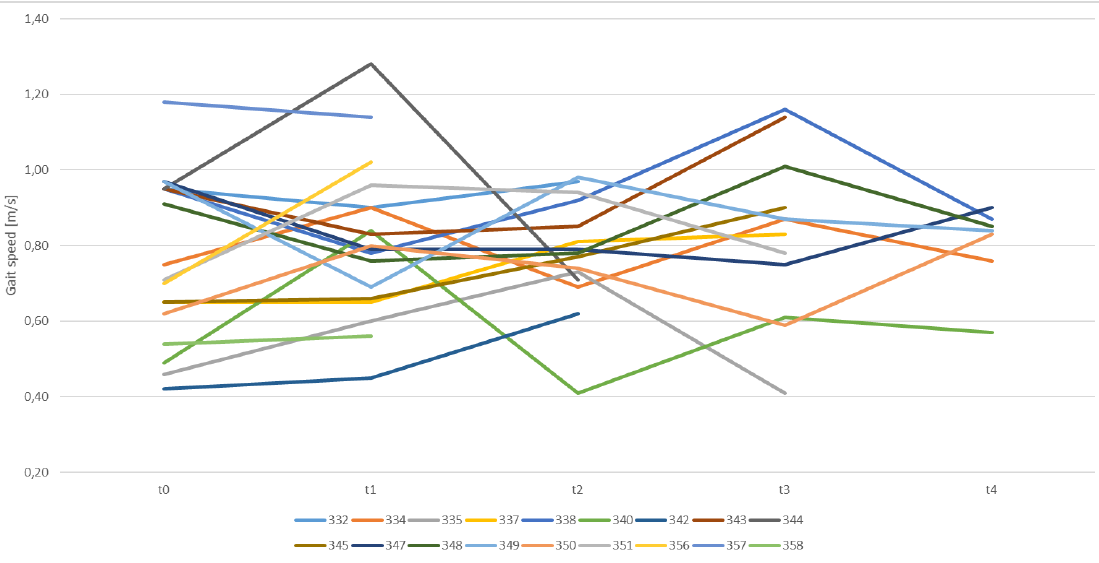
Figure 5: Individual changes in gait speed during the course of the